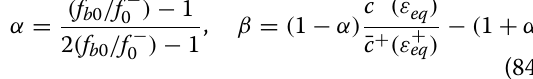
that some tensile cracks tend to close or